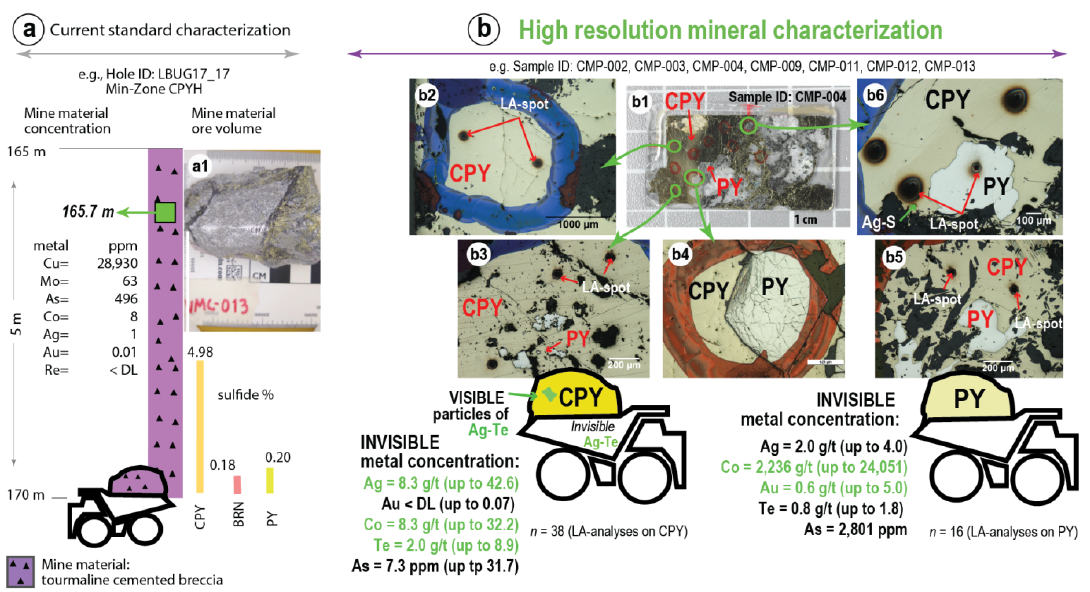
Figure 6. Schematic diagram illustrating: ( a ) the current Cu-sulfide ore characterization, which consist of bulk geochemical analyses performed on 5 m-composite samples of mine material (on the right side photograph is shown, a1). ( b ) The proposed multi-metal high-resolution characterization for the GMU2, indicating the mode of occurrence for each metal-bearing sulfide and the specific metal content, including the grade and style of appearance of each metal.